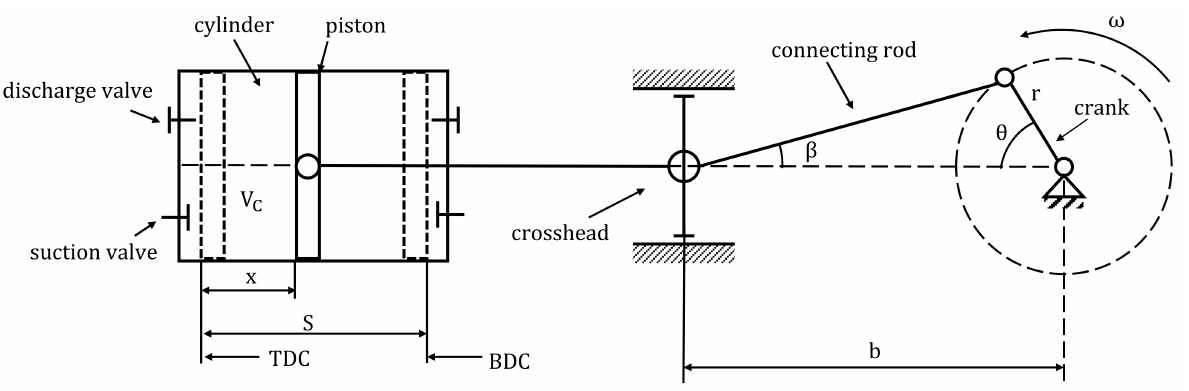
Figure 3. The schematic diagram of a reciprocating compressor. (Adapted with permission from ref. [18] 2022